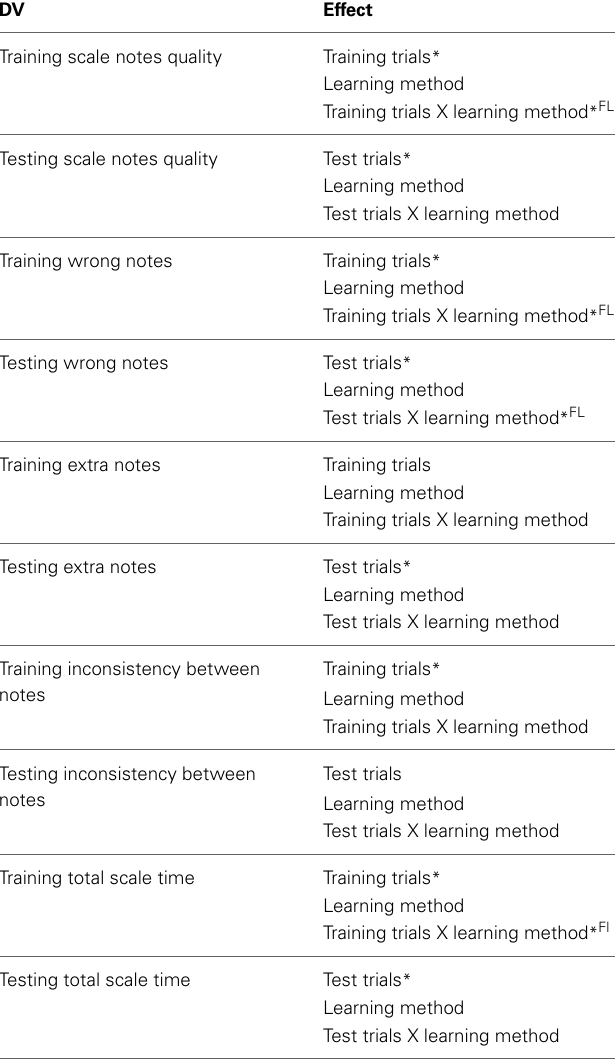
Table 1 | Summary of Experiment 1